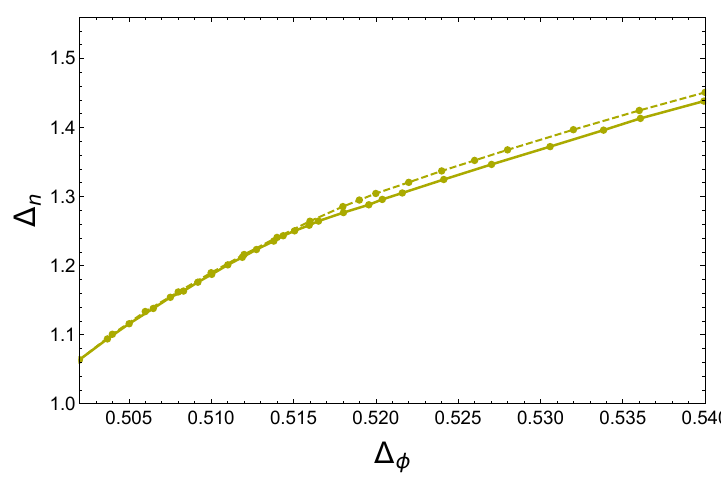
Figure 2 . Numerical bootstrap bound on the scaling dimensions of the first n-channel scalar operators in CFTs with S 4 Z 2 symmetry (small ∆ φ region). The dashed line is calculated at ⊗ Λ = 19, while the solid line is calculated at Λ = 27. If Λ is further increased, the change of the bounds is no long visible by naked